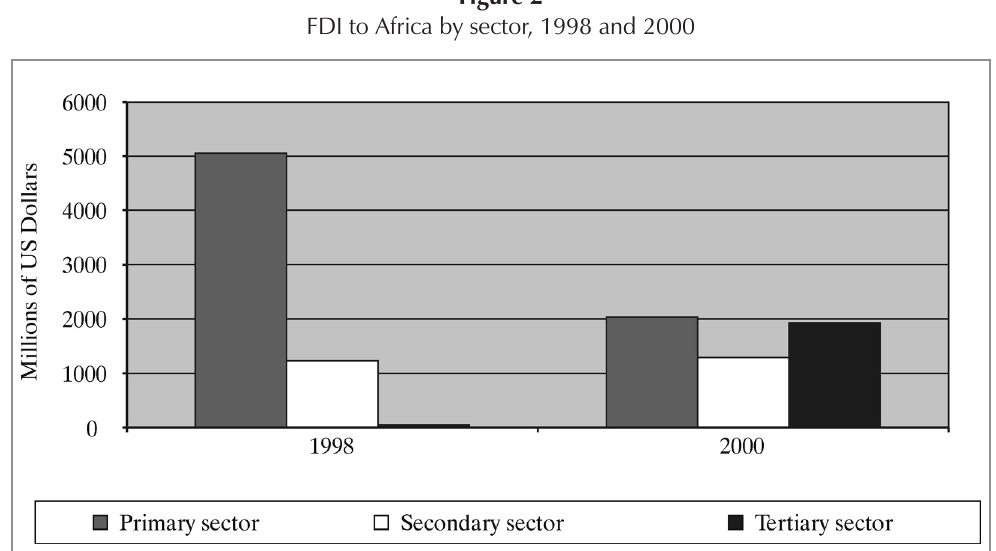
FDI to Africa by sector, 1998 and 2000